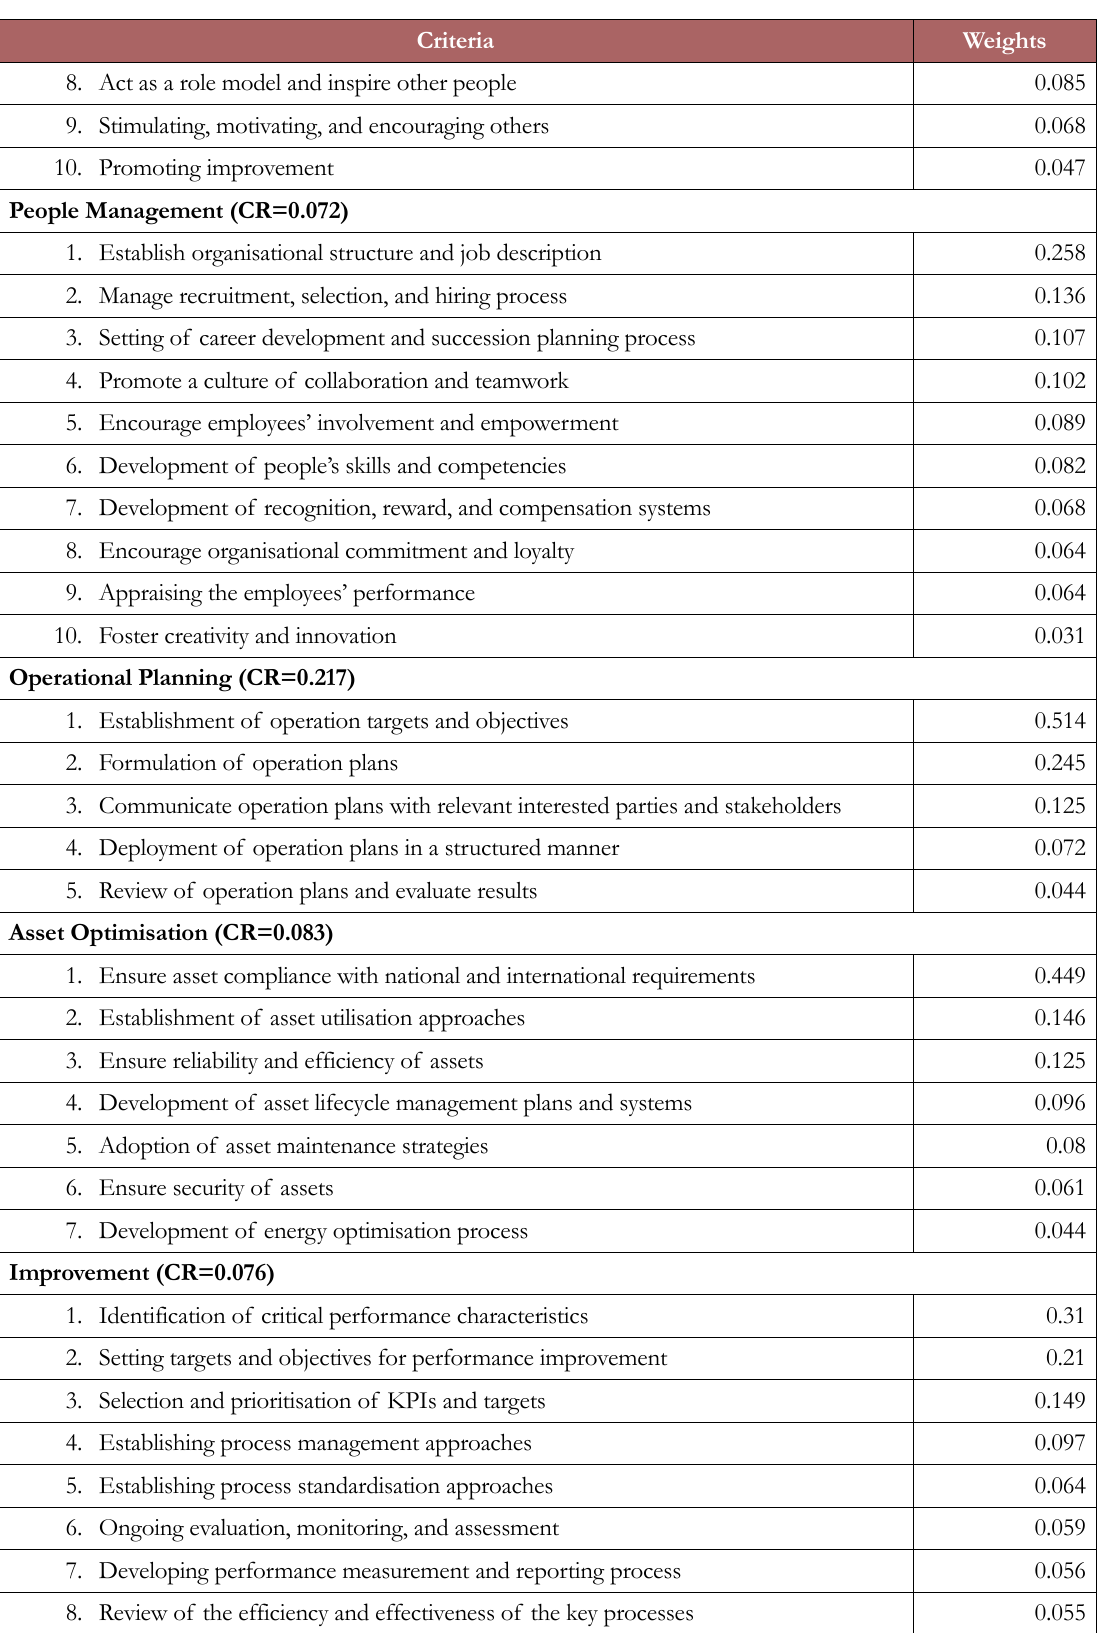
Table 7. Summary of Ranking for the 40 Subfactors Based on Local